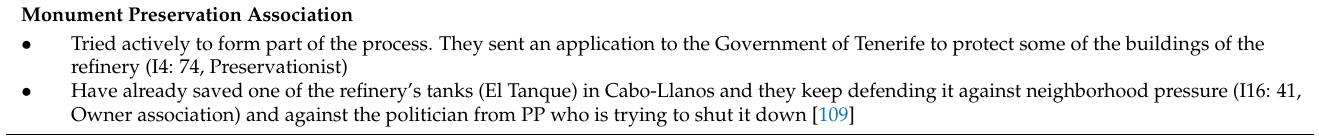
Table 4. Further relevant stakeholders.